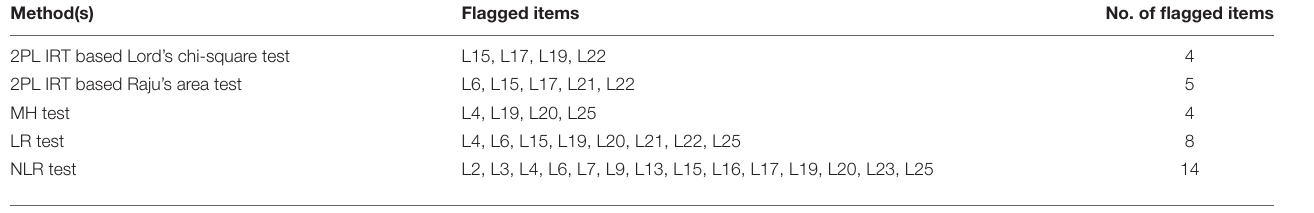
TABLE 3 | DIF items flagged by different methods.